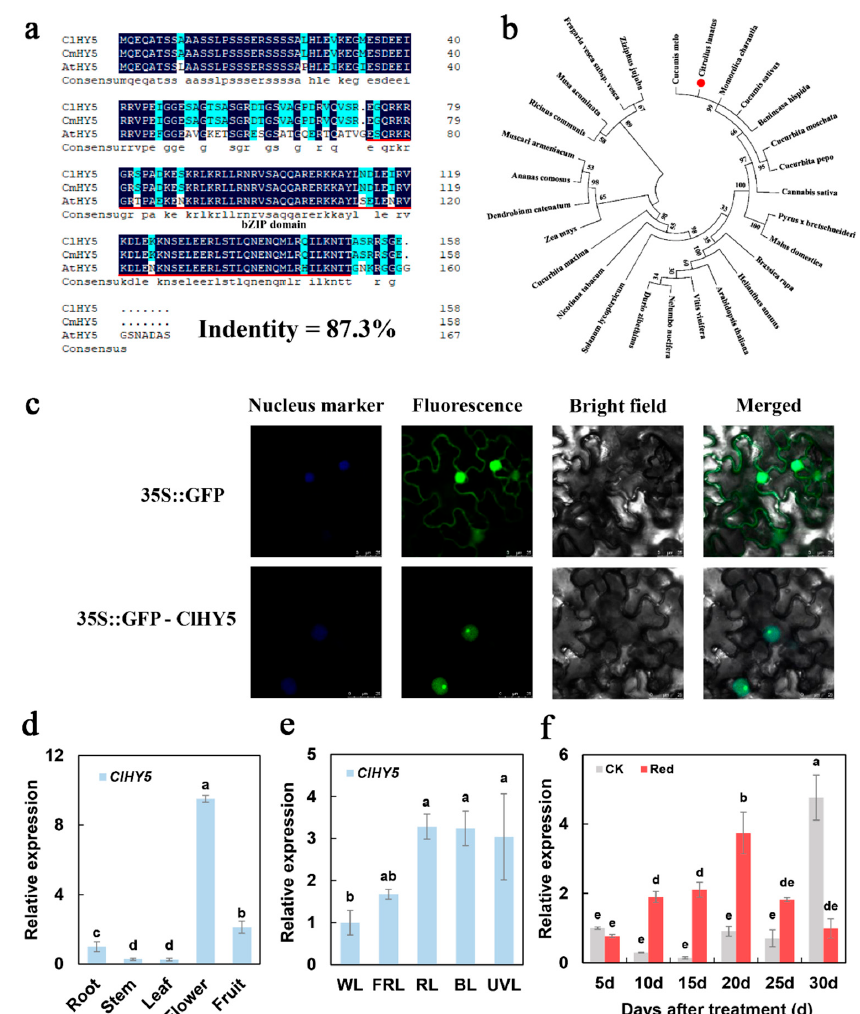
Figure 3. Sequence alignment, phylogenetic analysis, subcellular localization, and expression pattern of the ClHY5 gene. ( a ) Amino acid sequence alignment of ClHY5, CmHY5, and AtHY5. The sequence in black shadow represents the same sequence and the red line is the bZIP domain. ( b ) Phylogenetic tree of ClHY5 with other HY5 proteins from different plant species. ( c ) Subcellular localization of ClHY5 in N. benthamiana leaf cells and the green dots are GFP fluorescent protein. Bars = 25 µ m. ( d ) The expression levels of ClHY5 in different tissues. ( e ) Responses of ClHY5 in leaves to different types of light. WL, white light; FRL, far-red light; RL, red light; BL, blue light; UVL, UV light. ( f ) Response of ClHY5 to supplementary red lighting treatment during fruit development. The data showed mean values of three replicates (±SD) with three plants per replicate. The mean values of different letters were significantly different ( p < 0.05).